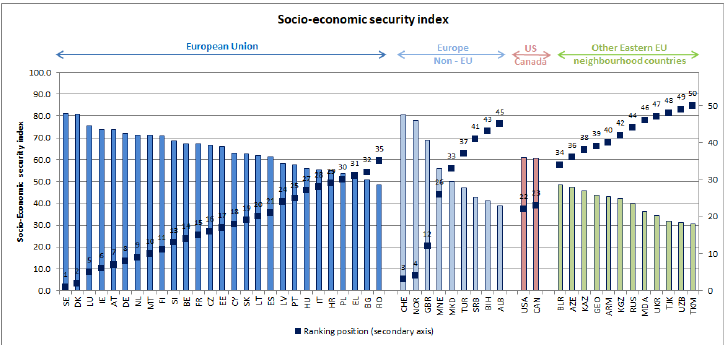
Figure 1. Socio-economic security index (source: own calculations using Microsoft Office Excel, based on the data presented in the methodology